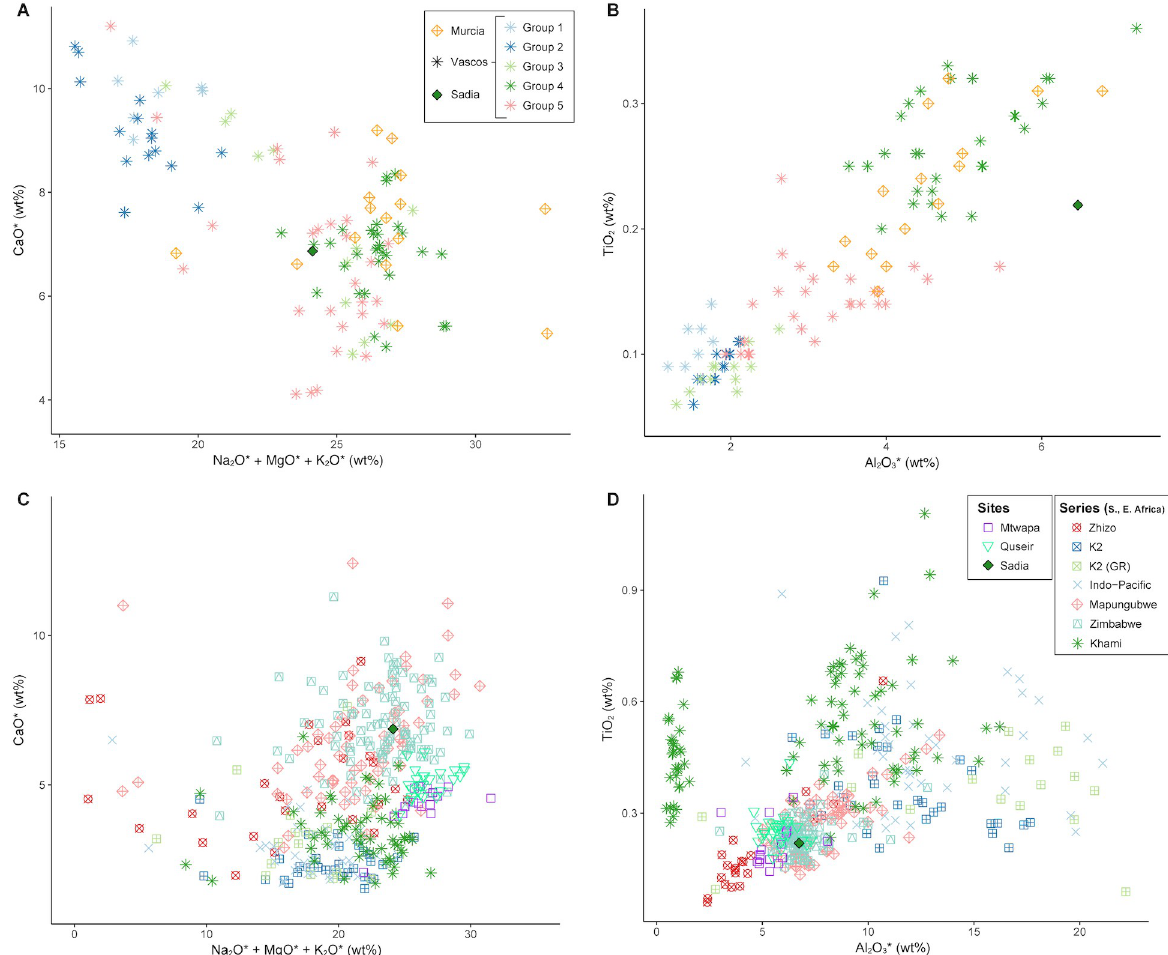
Fig 14. The Sadia glass bead compared to contemporary high alumina glasses. Lime versus the sum of soda, magnesia and potash (A, C) and titanium oxide versus alumina (B, D) of high alumina glass from Sadia compared to contemporary glasses from the Iberian Peninsula (A, B) and from eastern and southern Africa (C,